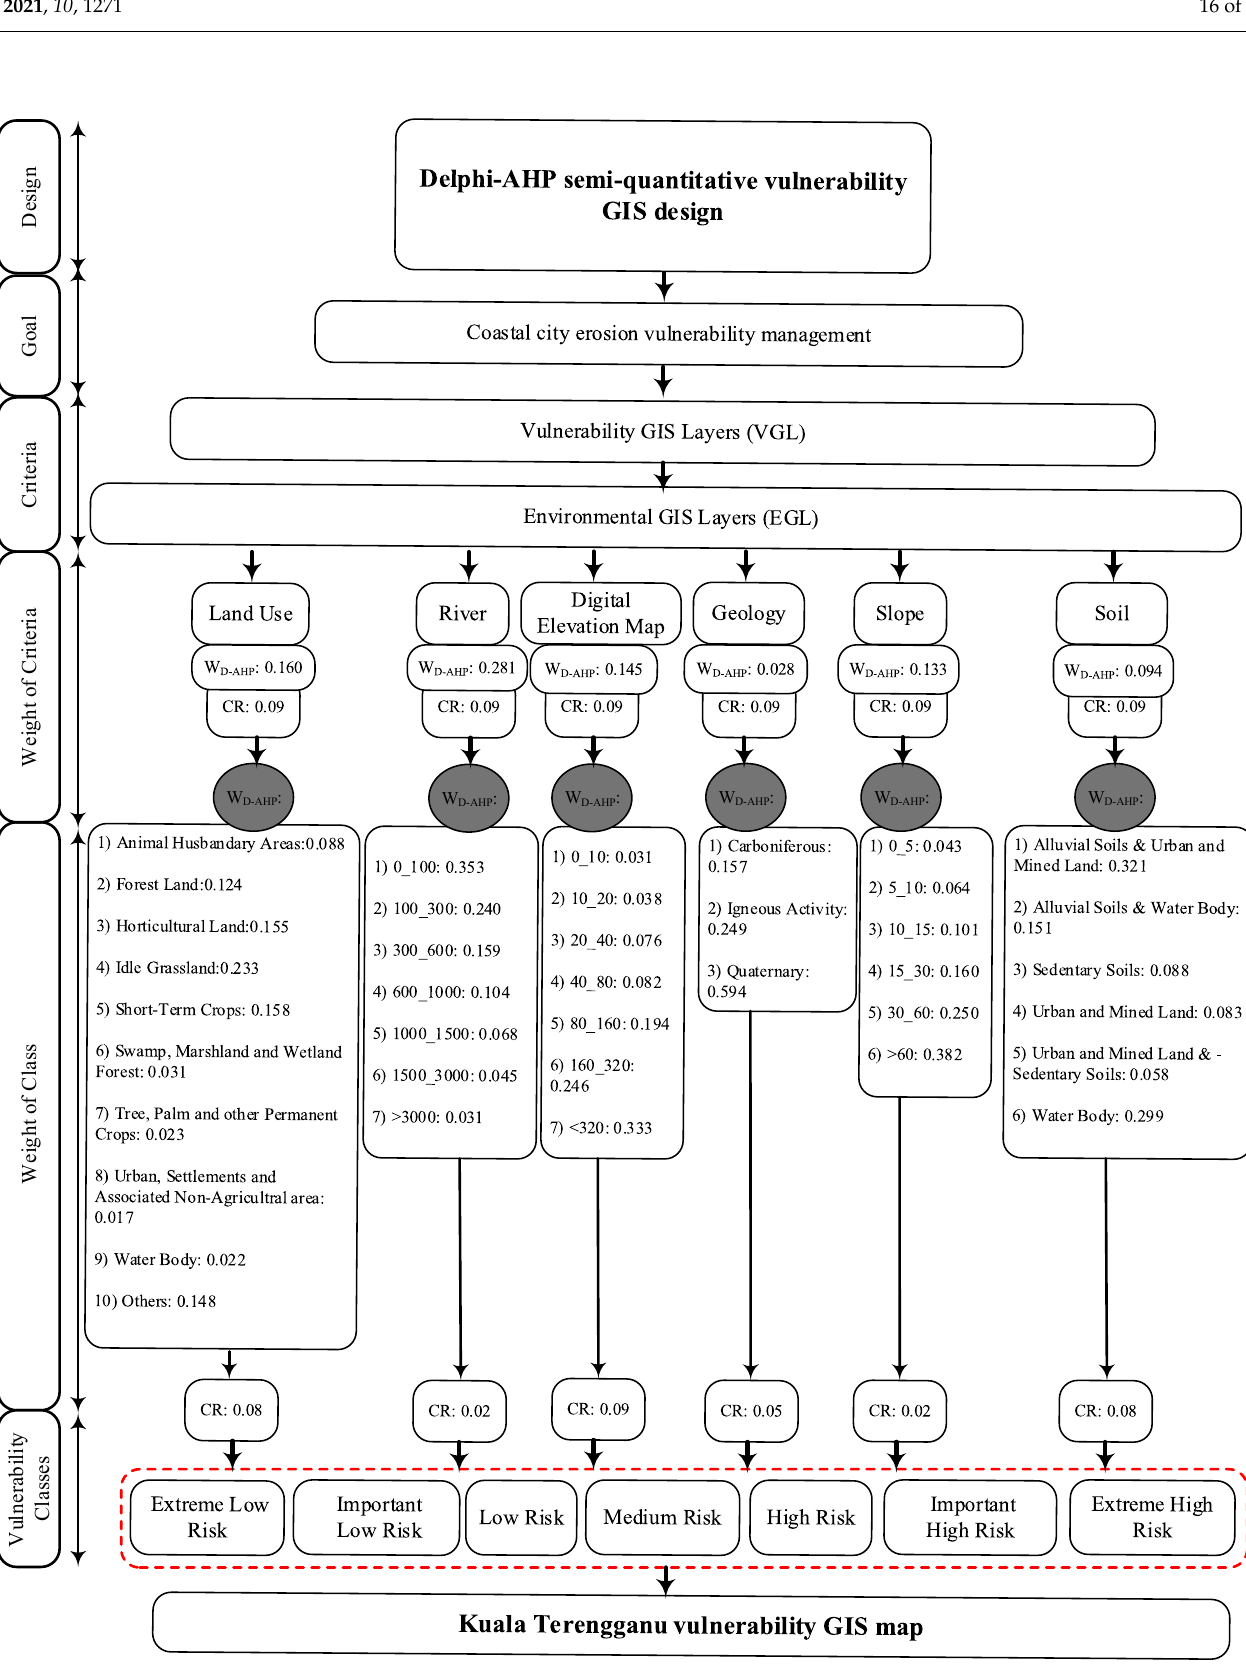
Figure 4. Delphi-AHP design and weights for EGL.